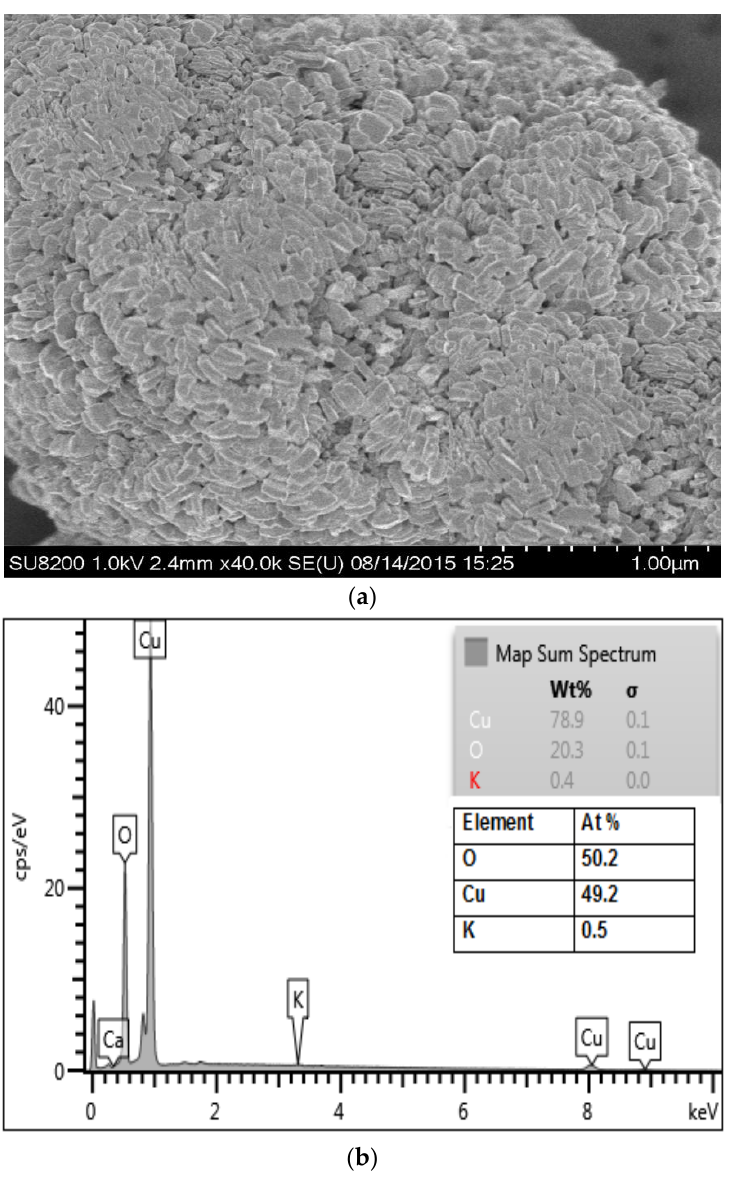
Figure 3. ( a ) Field emission scanning electron microscopy (FE-SEM) images and ( b ) energy dispersive X-ray (EDX) profile of plant-synthesized CuO nanoparticles.